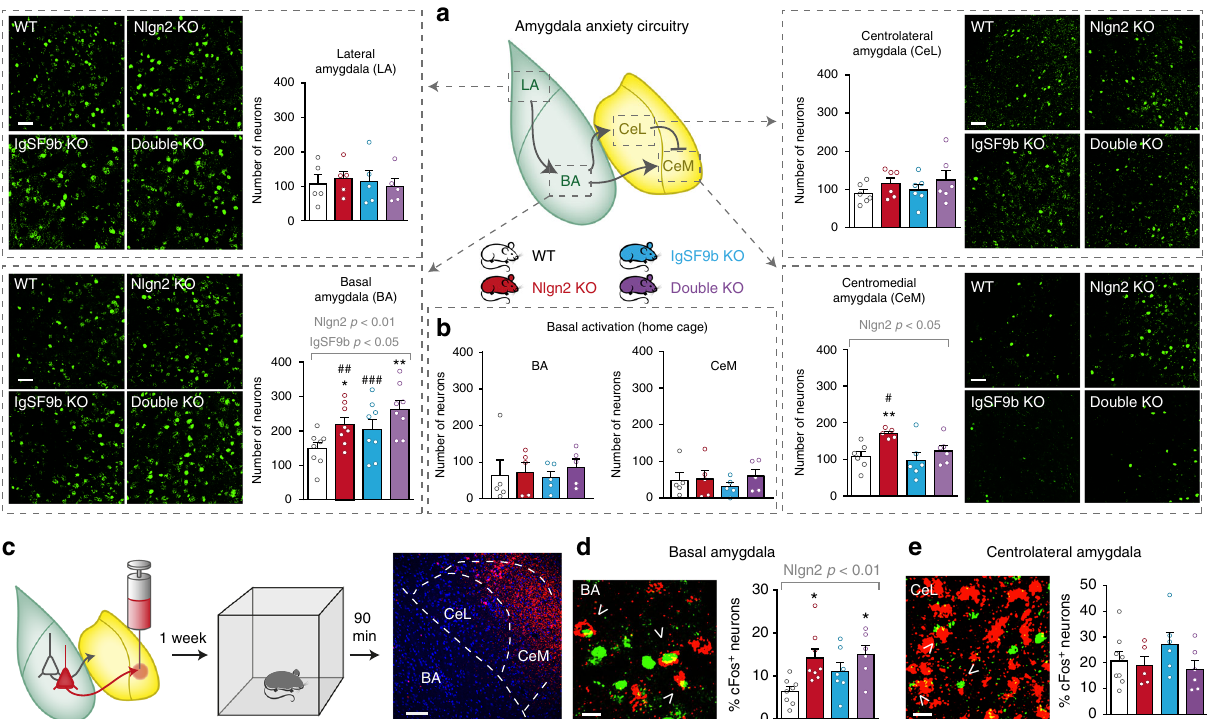
Fig. 2 Deletion of IgSF9b normalizes neuronal activation in the CeM of Nlgn2 KO mice. a cFos immunolabeling in the LA, BA, CeL, and CeM in all four genotypes. Representative images and quanti fi cation of cFos-positive cells in the LA (upper left panel), the BA (lower left panel), the CeL (upper right panel), and the CeM (lower right panel). Scale bar, 50 μ m. b Number of cFos-positive cells in the BA and CeM in WT, Nlgn2 KO, IgSF9b KO, and double KO mice under home cage conditions. c Experimental design of retrograde labeling. Mice were injected with Retrobeads into the CeM, and 1 week later they were exposed to the OF for 10min, perfused 90min later and analyzed for double labeling of cFos and Retrobeads in the BA and CeL. Scale bar, 100 μ m. d Representative image and quanti fi cation of cFos- and Retrobead-double positive cells in BA in all four genotypes. Scale bar, 20 μ m. e Representative image and quanti fi cation of cFos- and Retrobead-double positive cells in the CeL in all four genotypes. Scale bar, 20 μ m. Statistically signi fi cant ANOVA comparisons are marked in gray at the top of the panels and are listed in Table 1. For all other ANOVA comparisons, F < 1. Post-hoc analysis: * p < 0.05 relative to WT, ** p < 0.01 relative to WT, # p < 0.05 relative to double KO, ## p < 0.01 relative to double KO, ### p <0.001 relative to double KO. Error bars represent SEM, n = 5 – 8 mice per genotype. WT, white bars; Nlgn2 KO, red bars; IgSF9b KO, blue bars; double KO, purple shRNA, as evidenced by a signi fi cant increase in both the time and the distance traveled in the center (Fig. 4f – g, red vs. red and blue shaded bars, and Fig. 4h, representative traces). Interestingly, anxiety levels appeared to be exacerbated in Nlgn2 KO but not in WT mice over the observed 6-week time period, even in mice that had not undergone surgery (Supplementary Fig. 5b-d), and this effect was completely reversed by local reduction of IgSF9b (Fig. 4f – h, Supplementary Fig. 5e-f). Given that IgSF9b is highly